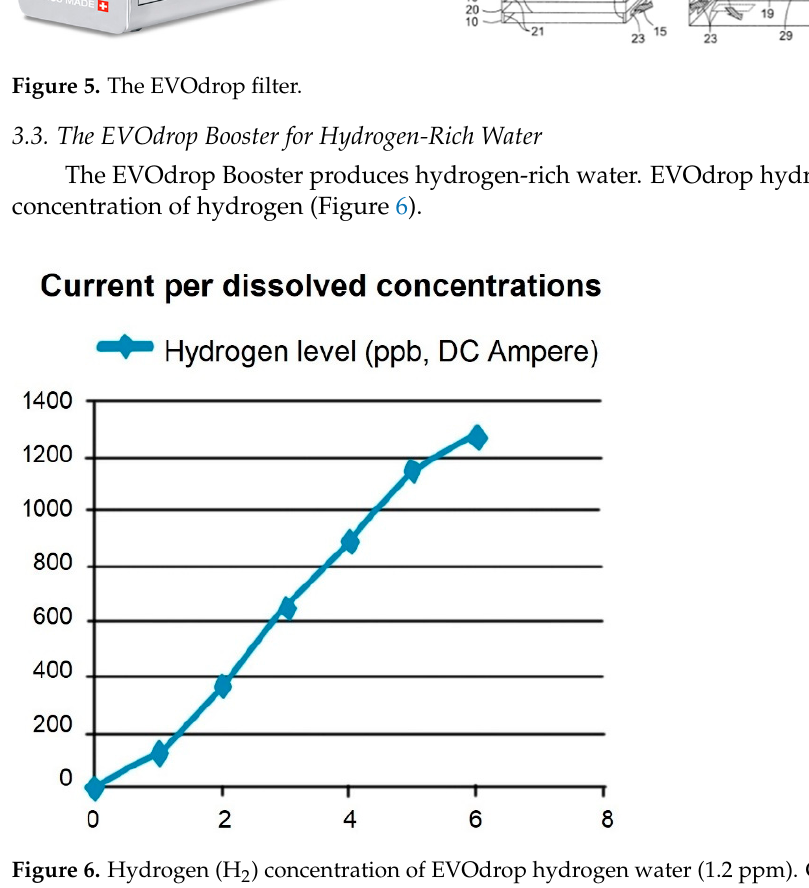
Figure 6. Hydrogen (H 2 ) concentration of EVOdrop hydrogen water (1.2 ppm). Correspondence of hydrogen concentration (ppb) of EVOdrop hydrogen water and the DC Current (Ampers). Figure 7 illustrates the EVObooster device for EVOdrop hydrogen